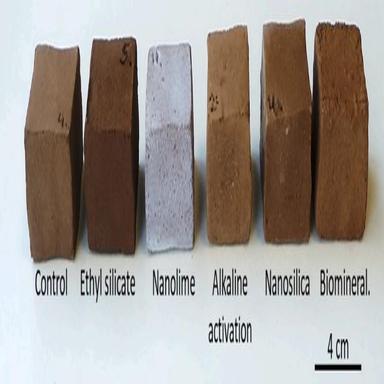
Photographic image of the earthen mock-ups before (control, CON) and after the application of the consolidation treatments.